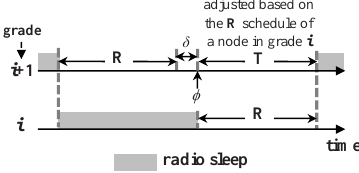
Figure 4. Guard time δ between R and T